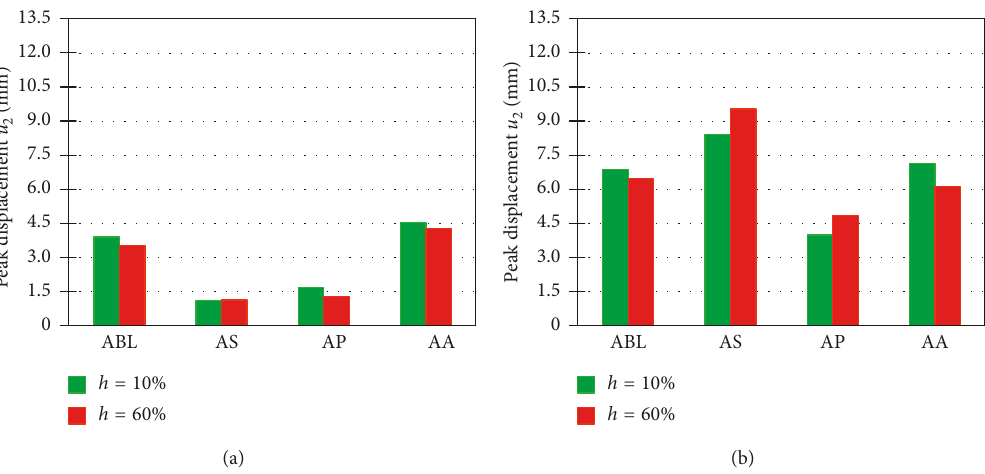
Figure 22: The effect of pebble layer moisture on peak horizontal displacement u